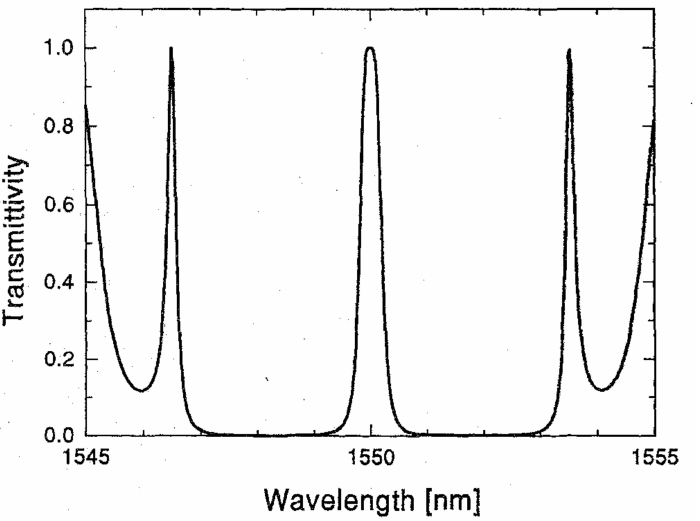
Figure 2. Transmission spectrum of a PS-FBG where a phase-shift of π is inserted at middle of the FBG. Adapted with permission from ref. [7]. © [2022]